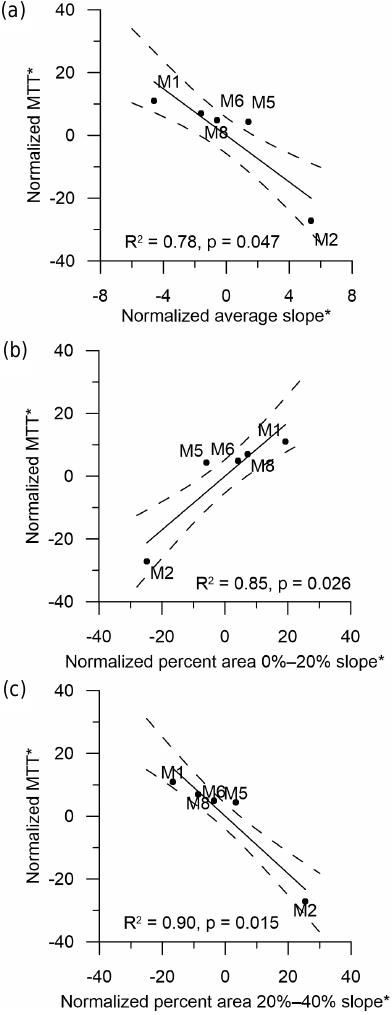
Figure 6. Correlations between mean transit time (MTT) and to- pographic indexes of the catchments: (a) average catchment slope; (b) catchment area with slopes between 0 and 20%; and (c) catch- ment area with slopes between 20 and 40%. Catchments M3 and M4 (additional spring water source; see Fig. 1) and M7 (at a flat hilltop disconnected from the hillslopes) are not included in the re- gressions. Solid lines are linear regressions and dashed lines are the 90% confidence intervals of the regressions. ∗ indicates variables are normalized by their